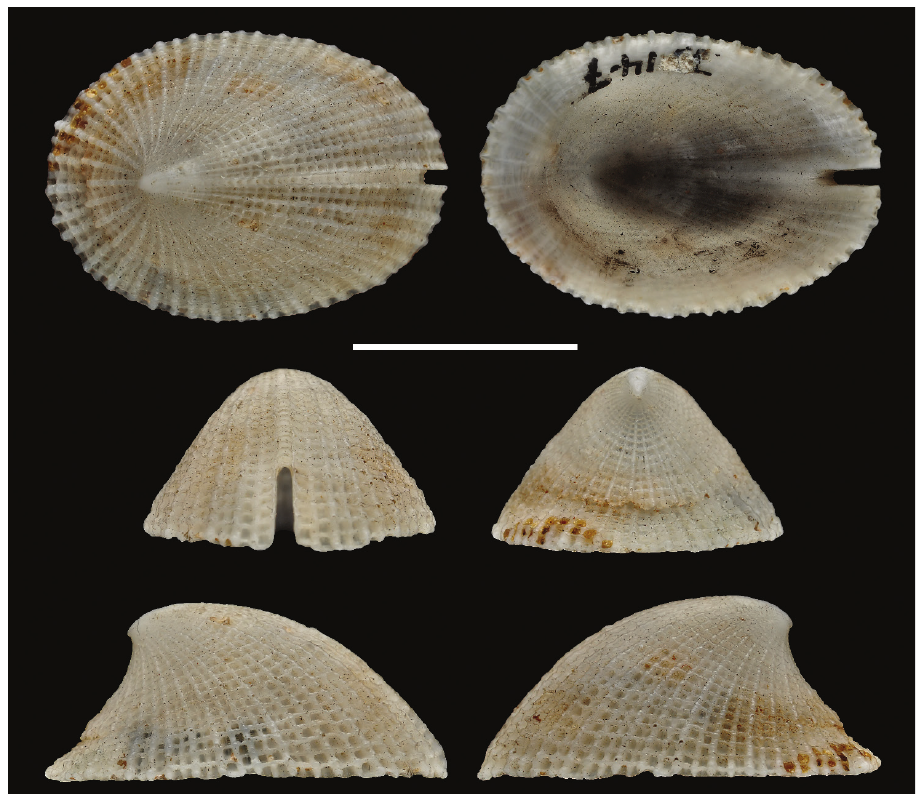
Figure 6. Emarginula koon Kilburn, 1978. Holotype T2196/NMSA-MOL 0B147. Scale bar: 10